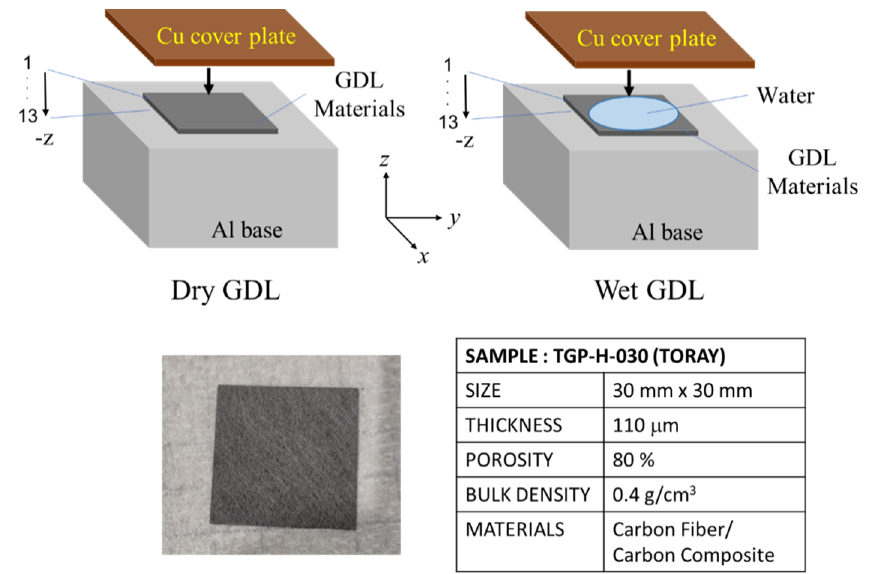
Figure 2. Samples of the GDL (Gas Diffusion Layer) material, dry or wet, used for the Compton scattering imaging.